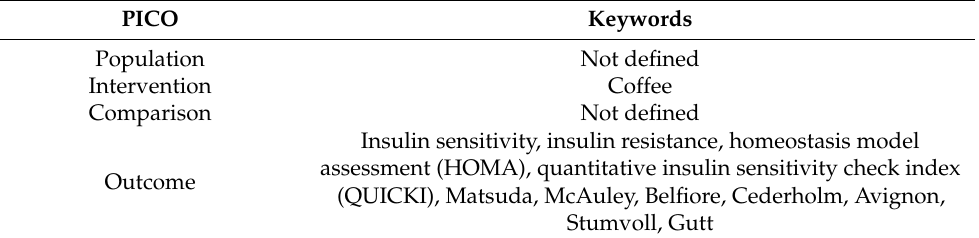
Table 1. Population, intervention, comparison, and outcome (PICO) search strategy.